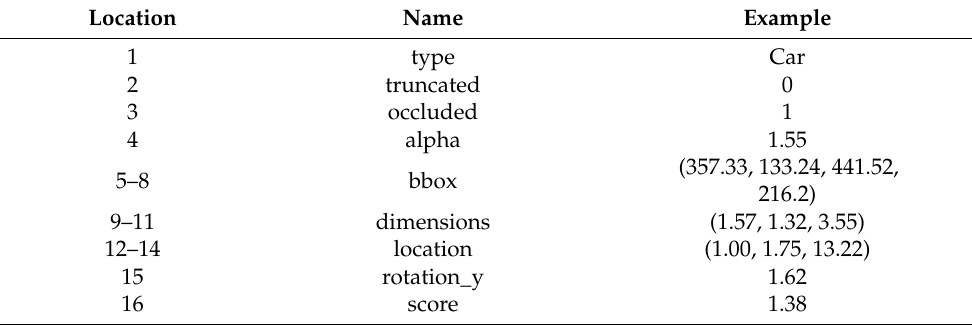
Table 1. The detection results from OpenPCDet on